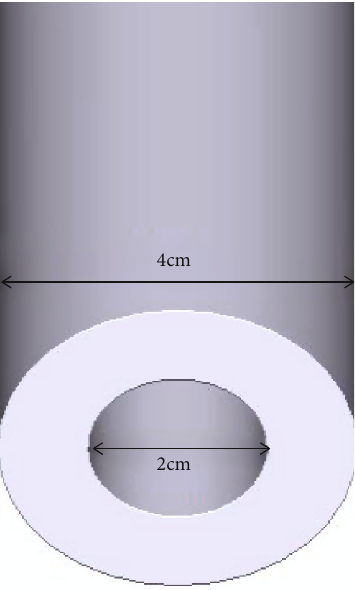
Figure 13: The tracking axis in the form of a hollow